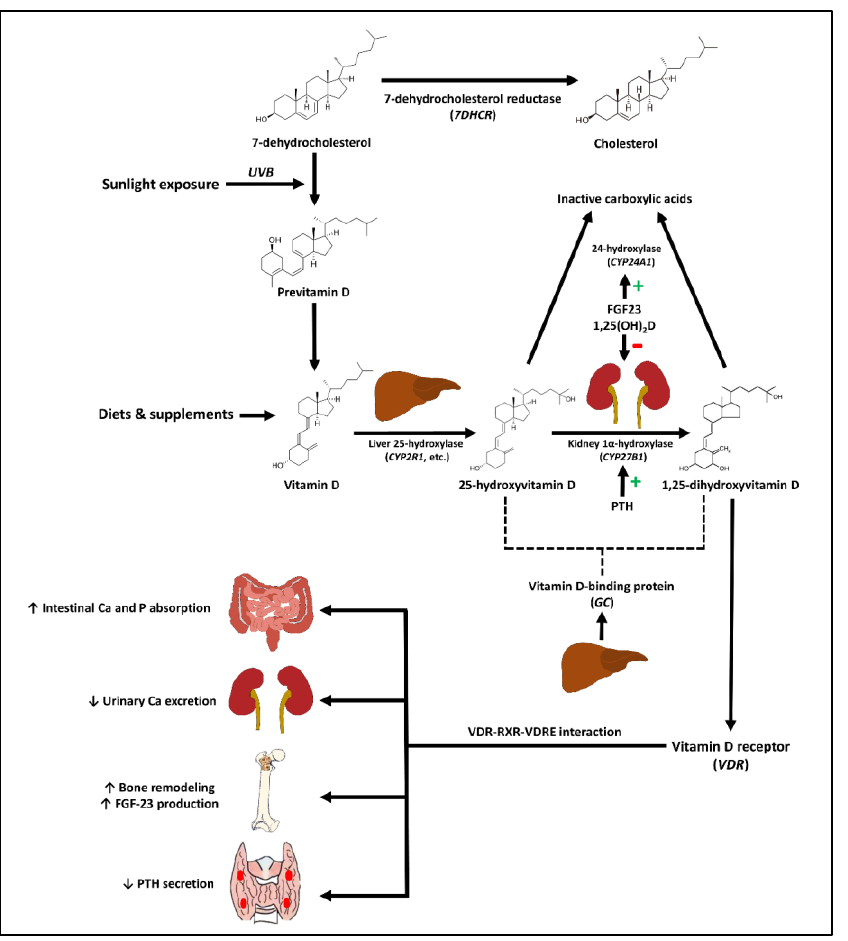
Figure 1. Schematic representation of vitamin D metabolic pathway and the effects of vitamin D on calcium and phosphate homeostasis. Abbreviations: Ca: Calcium; FGF-23; Fibroblast growth factor-23; P: Phosphate; PTH: Parathyroid hormone; UVB : Ultraviolet-B radiation.